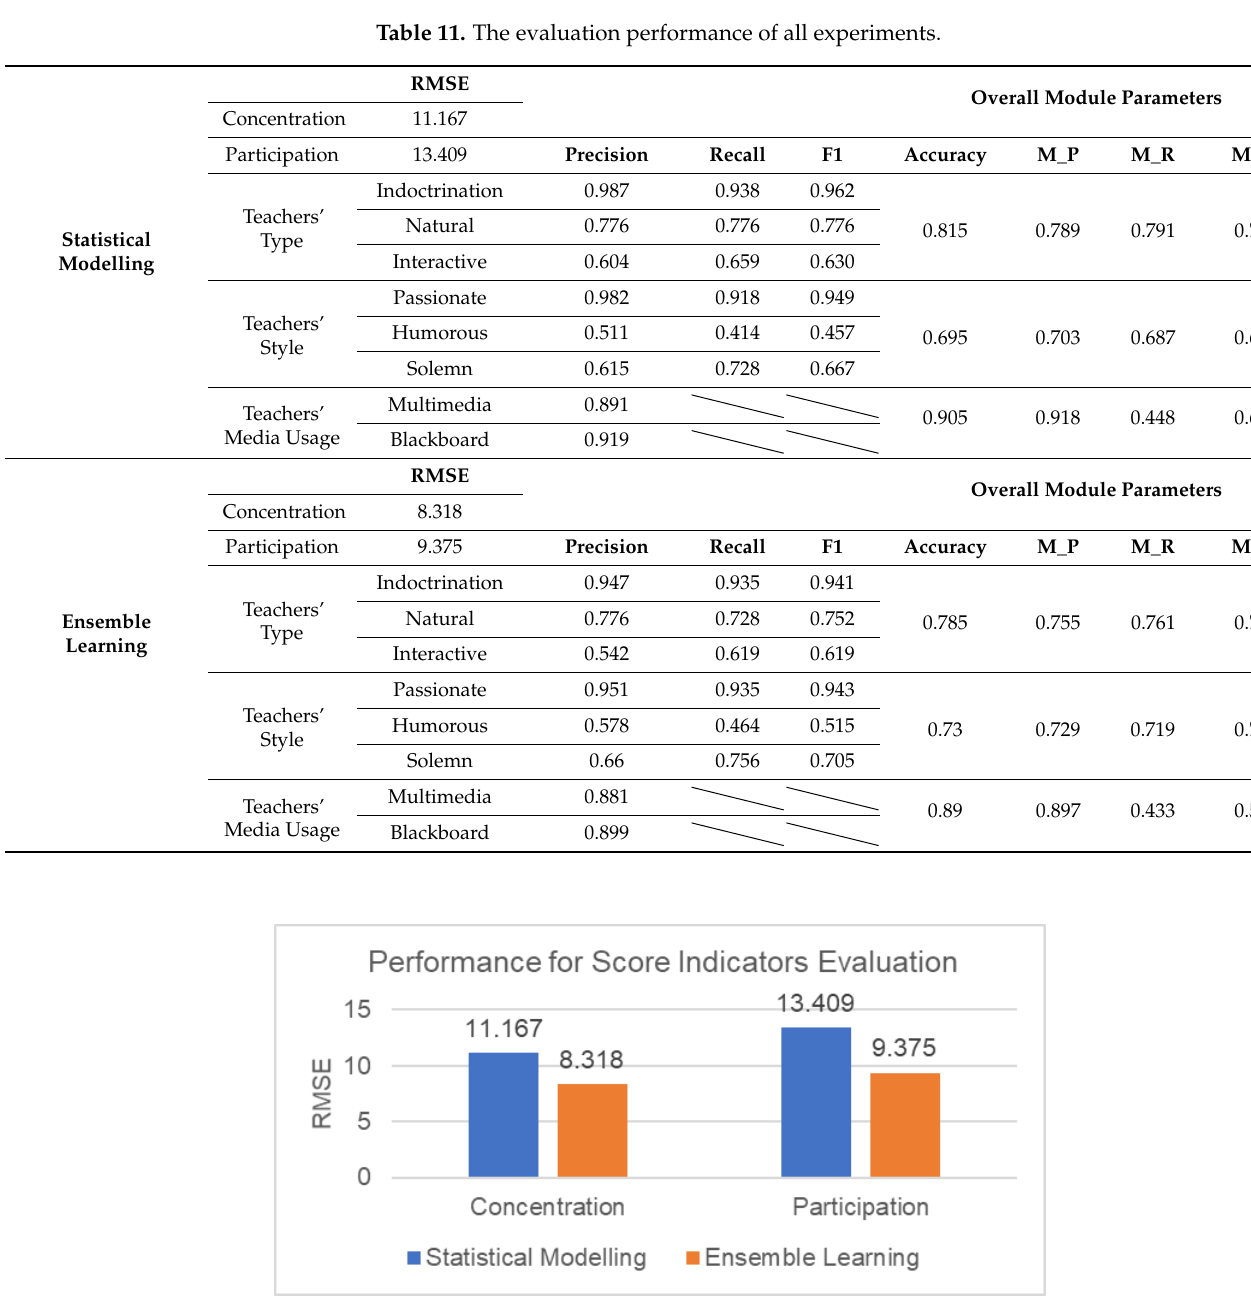
Table 11. The evaluation performance of all experiments.